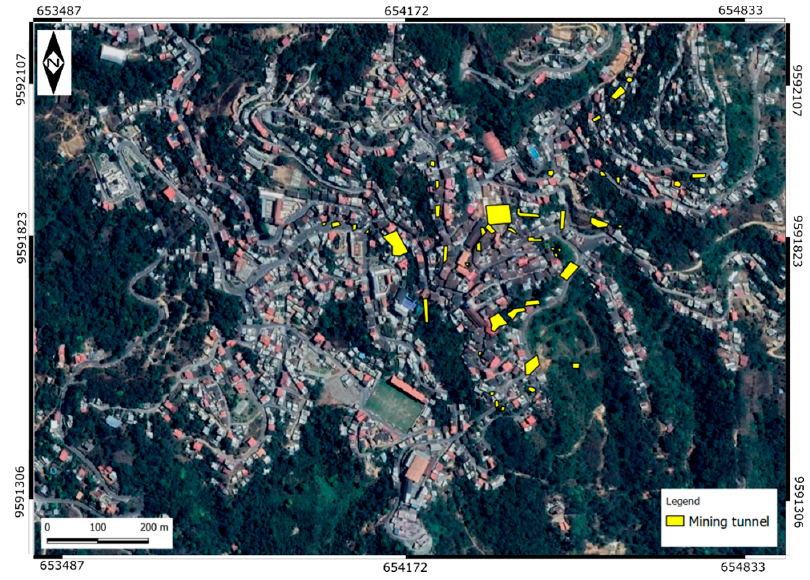
Figure 3. Mining tunnels in the Zaruma urban area (modified from [30]).